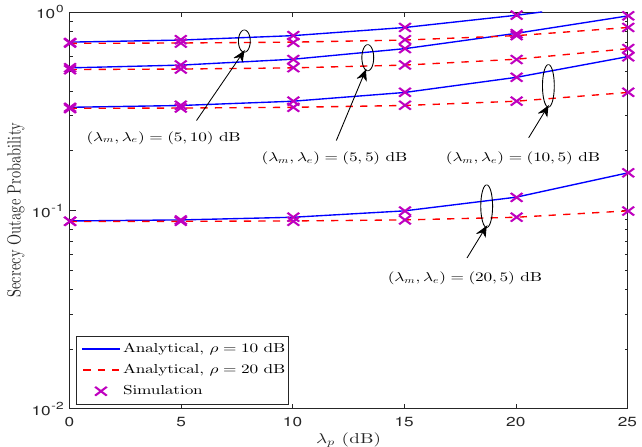
Figure 6. Impact of PR on the SOP performance under Strategy I.